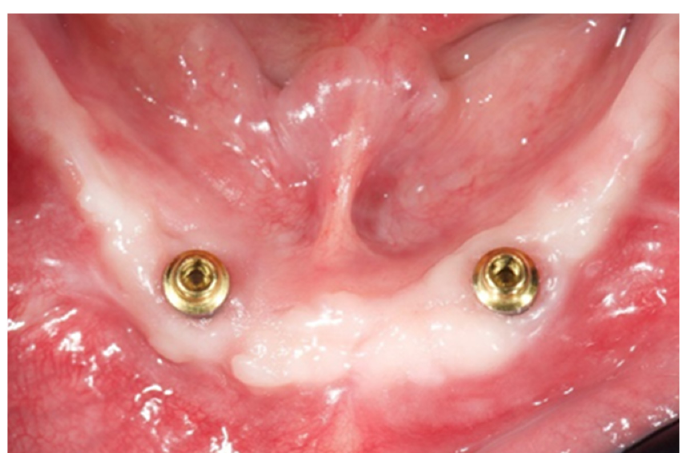
Figure 6. Placed implants with OT Equators (Rhein’83, Bologna, Italy).